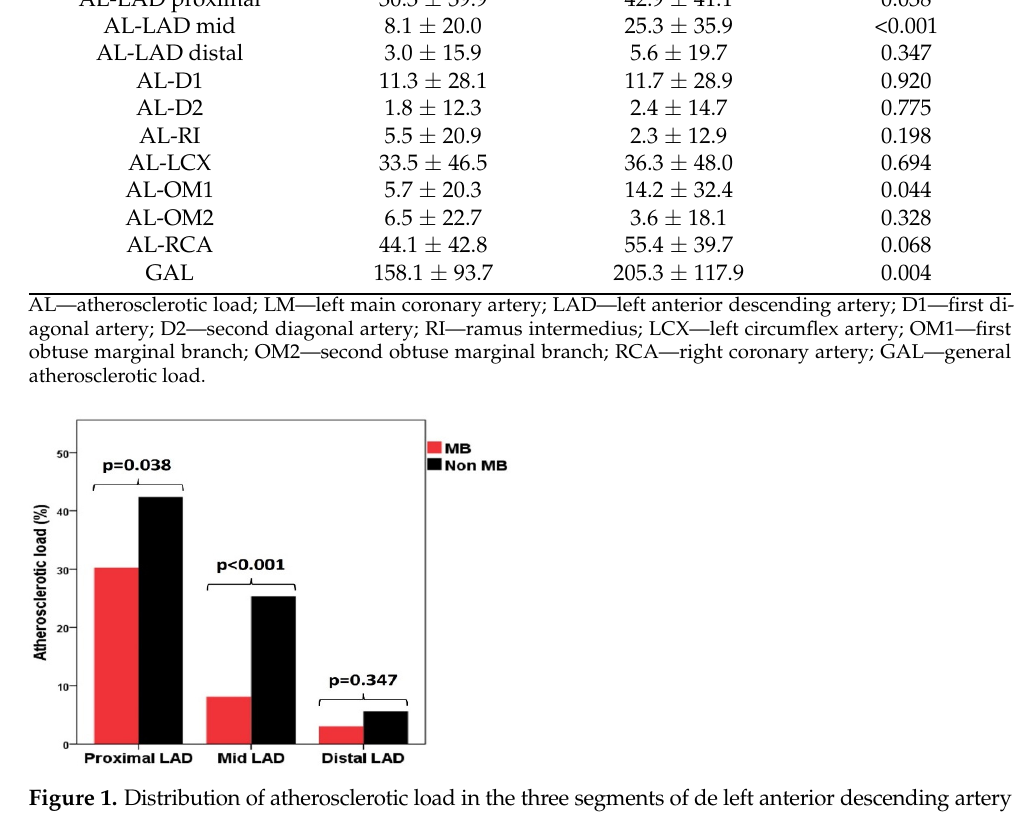
Figure 2. Distribution of atherosclerotic load between the proximal and distal segment of the left anterior descending artery in MB group and non-MB group. LAD—left anterior descending artery; MB—myocardial bridge. Based on Multinominal Logistic Regression, we found that the presence of MB on LAD is a protective factor against the atherosclerotic lesions (the negative value of the B value). In all four regression models, the presence of the MB (regardless of its location on LAD) is decreasing the probability of significant atherosclerotic stenosis, especially of those more than 70% (Tables 4–7).